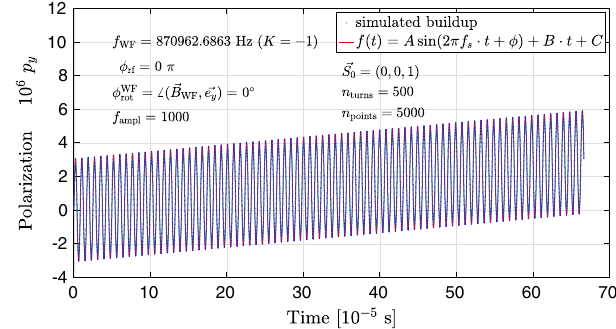
FIG. 8. Horizontal and longitudinal polarization components ð t Þ and p ð t Þ during ten turns in the machine, as described by p x z S 2 ð t Þ using Eq. (42) for the K ¼ − 1 harmonic and an initial ⃗ S 0 in the horizontal ( xz ) plane. The magnetic field polarization ⃗ B WF of the rf Wien filter points along ⃗ e indicated are bunch revolution and Wien filter rf frequency, and the corresponding rf amplitude when the beam bunch meets the Wien filter rf (pink filled circle).